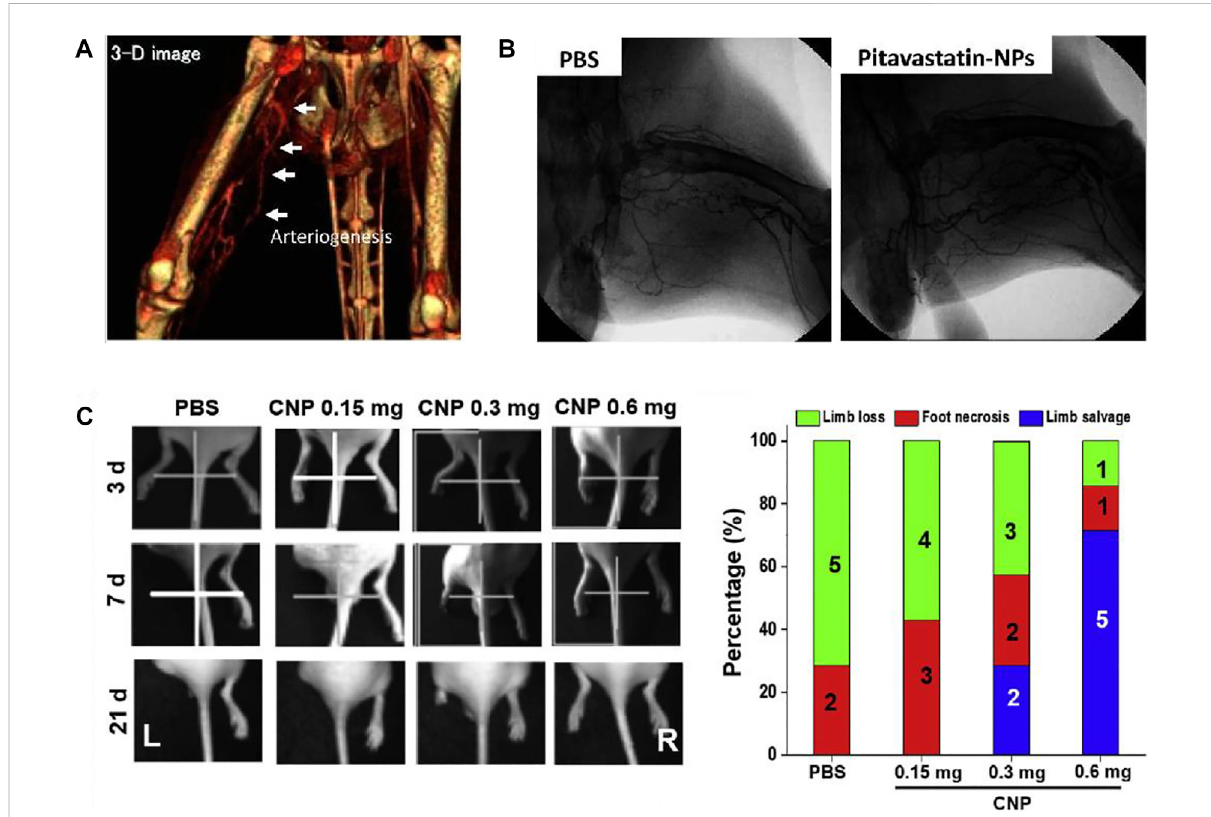
FIGURE 12 Schematic diagrams of nanoparticles to improve blood perfusion. (A) Representative angio-CT images demonstrated the development of collateralarteries. (B) Representativeimagesofangiographyofischemiclowerextremities.Thepitavastain-NPsgroupshowedtherevascularization. (C) Representative images of limb loss in different treatment groups and quanti fi cation of limb loss, foot necrosis, and limb salvage. The CNP 0.6 mg group showed the best effect of limb salvage. (A,B) are reprinted with permission from ref. (Matsumoto et al., 2020). (C) is reprinted with permission from ref. (Park et al.,